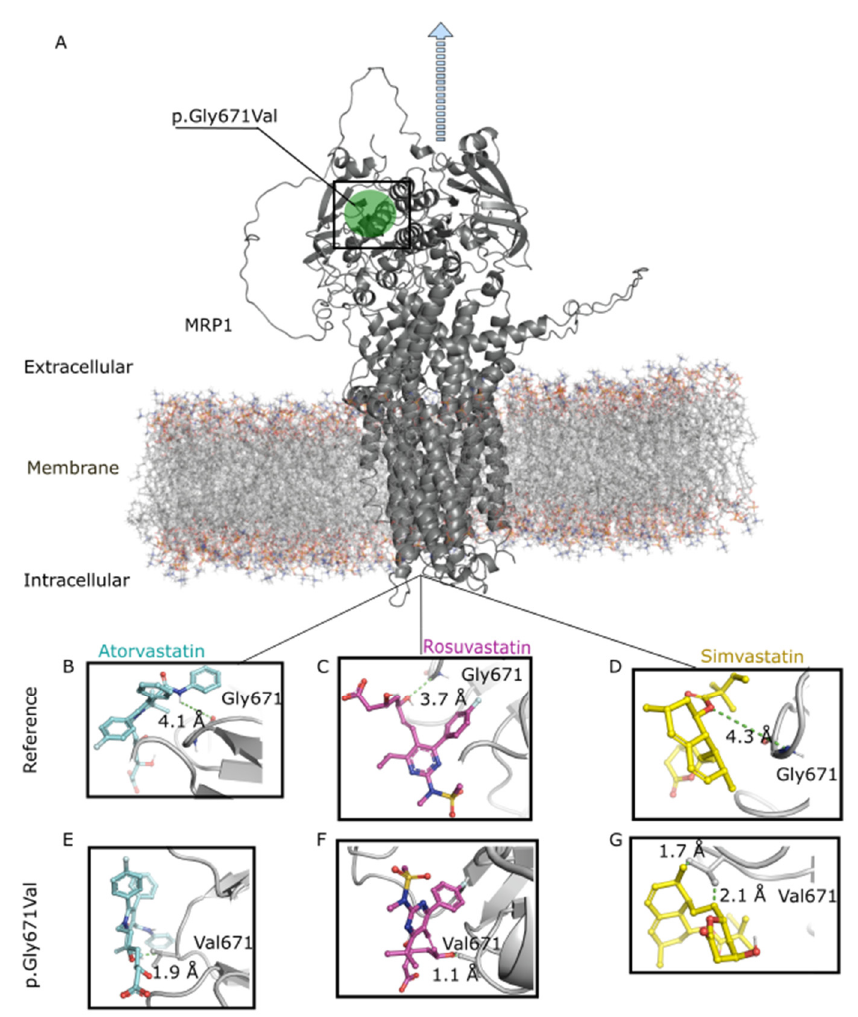
Figure 3. Molecular modeling analysis. Influence of ABCC1 rs45511401 (c.2012G>T, p.Gly671Val in MRP1) on amino-acid interaction with statins. ( A ) Representation of MRP1 (encoded by ABCC1 ) anchored in the basolateral membrane of a hepatocyte. The blue arrow indicates the sense of statin efflux. ( B – D ). Interactions between reference MRP1 (Gly671) and atorvastatin, rosuvastatin, and simvastatin, respectively. ( E – G ). Interactions between MRP1 variant (Val671) and atorvastatin, rosuvastatin, and simvastatin, respectively.